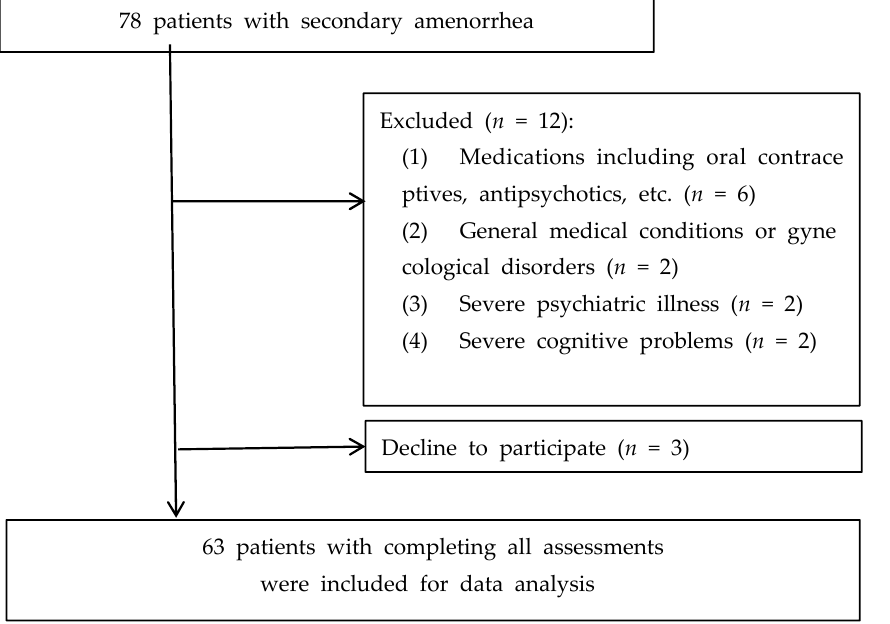
Figure 1. Flow chart of the study population.